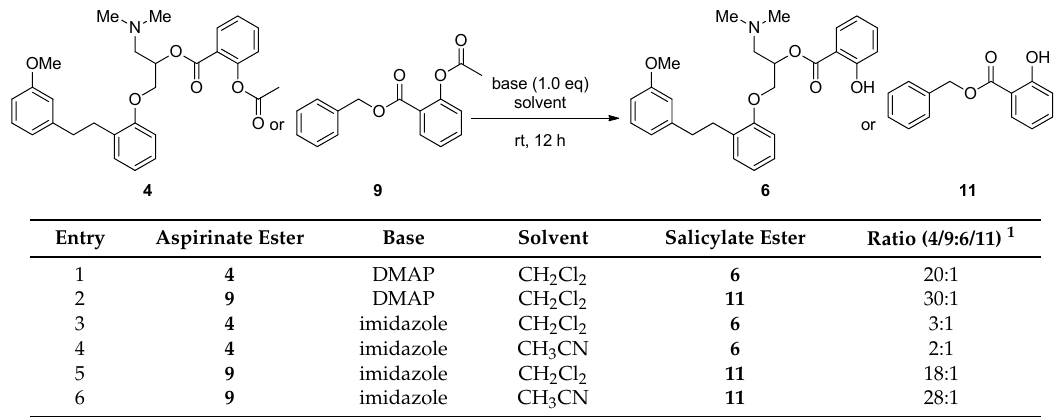
Table 3. Deacetylation of aspirinate esters 4 and 9 by bases.